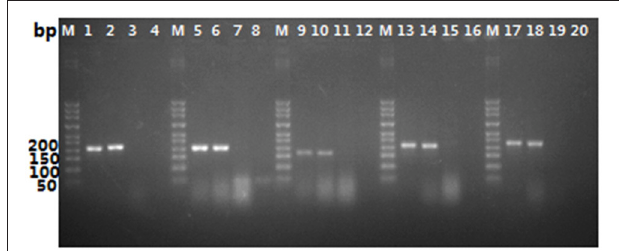
FIGURE 4 | Ampification results for PCR with primer pairs CCF/CCR, CGF/CGR, CMF/CMR, ONF/ONR, and CLF/CLR. CCF/CCR (lane 1–4), CGF/CGR (lane 5–8), CMF/CMR (lane 9–12), ONF/ONR (lane 13–16), CLF/CLR (lane 17–20); lane1, 5, 9, 13, and 17, pure DNA isolated from targeted species ( C. cicadae, C. gunnii , C. militaris, O. nutans, and C. liangshanensis , respectively); lane 2, 6, 10, 14, and 18, mixture of DNA isolated from O. sinensis and the targeted species ( C. cicadae, C. gunnii , C. militaris, O. nutans, and C. liangshanensis , respectively) at a ratio of 1:1; lane 3, 7, 11, 15, and 19, pure DNA of O. sinensis ; lane 4, 8, 12, 16, and 20, negative control.